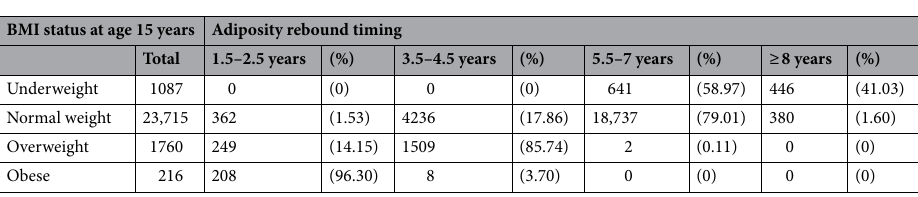
Table 2. Timing of adiposity rebound and BMI status at age 15